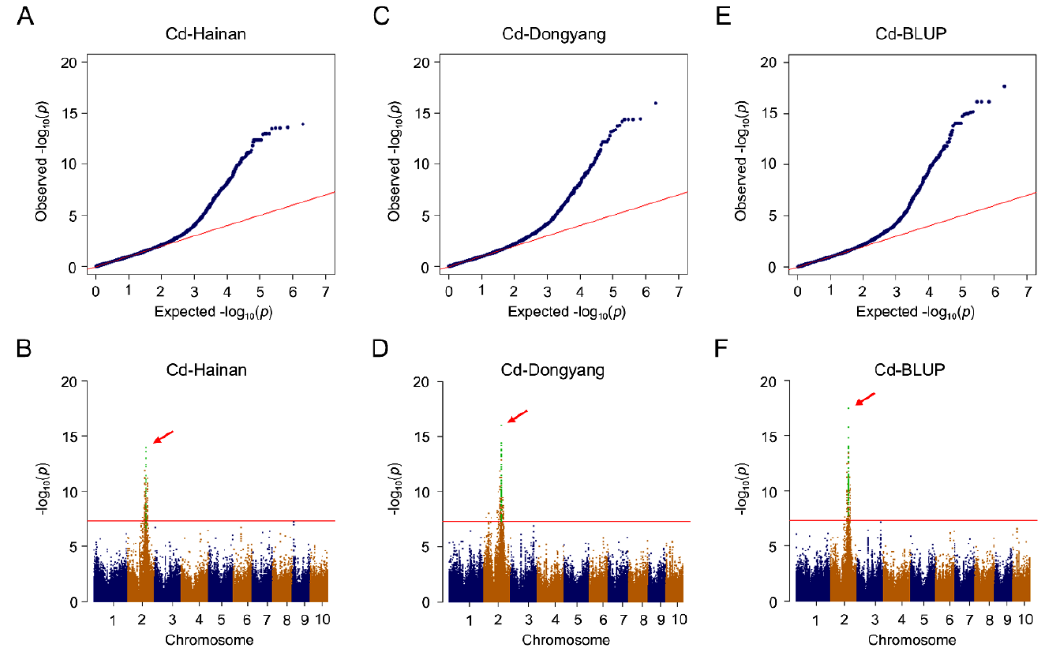
Figure 4. Presentation of a few highly reproducible and significant Q–Q Plots and Manhattan for Cd. ( A ) Quantile–quantile (Q–Q) plots showing inflation of estimated − log 10 ( p ) values versus observed for traits Cd in Hainan using Q + K (MLM). Q represent 31 principal components (fixed), K represents a kinship matrix (random), GLM represents the general linear model, MLM represents the mixed linear model. ( B ) Manhattan plot from the Q + K (MLM) model for Cd in Hainan, plotted with the individual SNPs of all chromosomes on the X-axis and − log 10 ( p- value) of each SNP in the Y-axis. The different colors indicate the 10 chromosomes of maize. The red horizontal line shows the multiple testing threshold − log 10 ( p -value) of 7.4 for this panel. The SNPs located within the candidate genes, as identified by the GWAS of the whole population, are labeled as green dots. ( C ) Q–Q plots for GWAS of traits Cd in Dongyang. ( D ) Manhattan plot for GWAS of traits Cd. ( E ) Q–Q plots for GWAS of traits Cd-BLUP. Cd-BLUP represents the best linear unbiased prediction of Cd in Hainan, Dongyang and Xinxiang. ( F ) Manhattan plot for GWAS of traits Cd-BLUP. Table 4. The candidate genes included in the region detected by genome-wide association study.